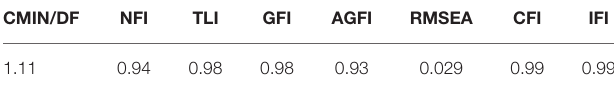
TABLE 5 | Model fit summary of structural equation modeling ( N = 500). CMIN/DF